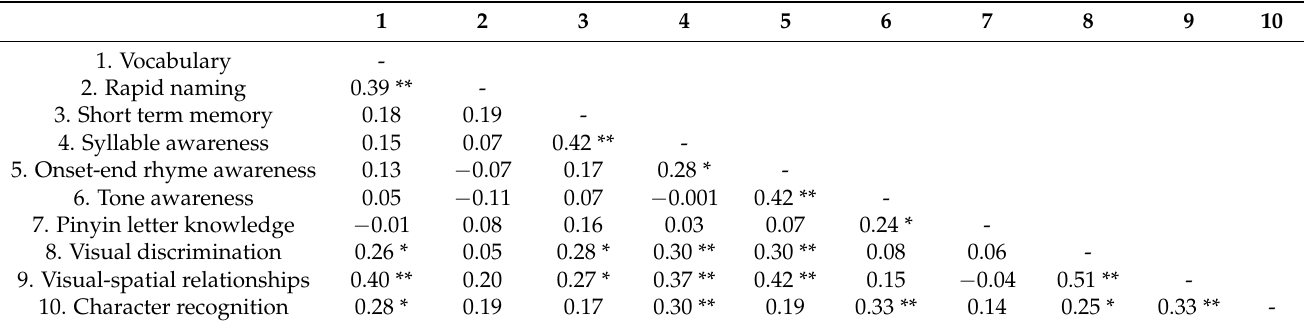
Table 2. Correlations between vocabulary, two phonological processing skills, phonological aware- ness, Pinyin letter knowledge and visual perception skills and character recognition (N =